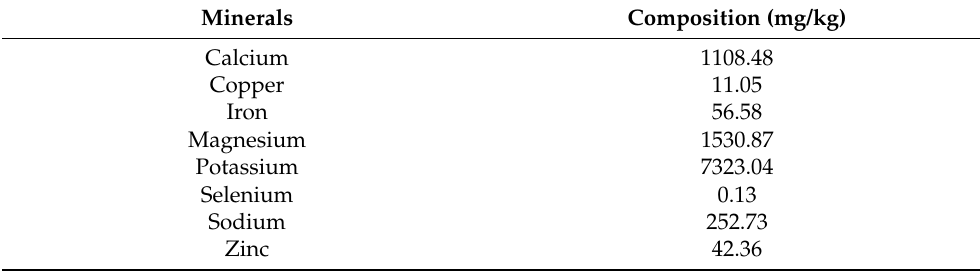
Table 3. Mineral and vitamin contents of bee